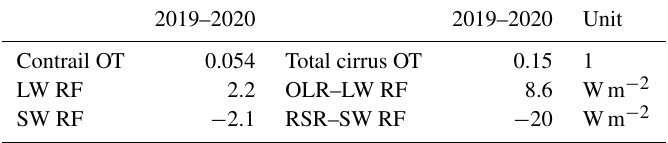
Table 4. Extreme changes in the 6-months mean values of contrail and total cirrus OT and irradiances between 2019 and